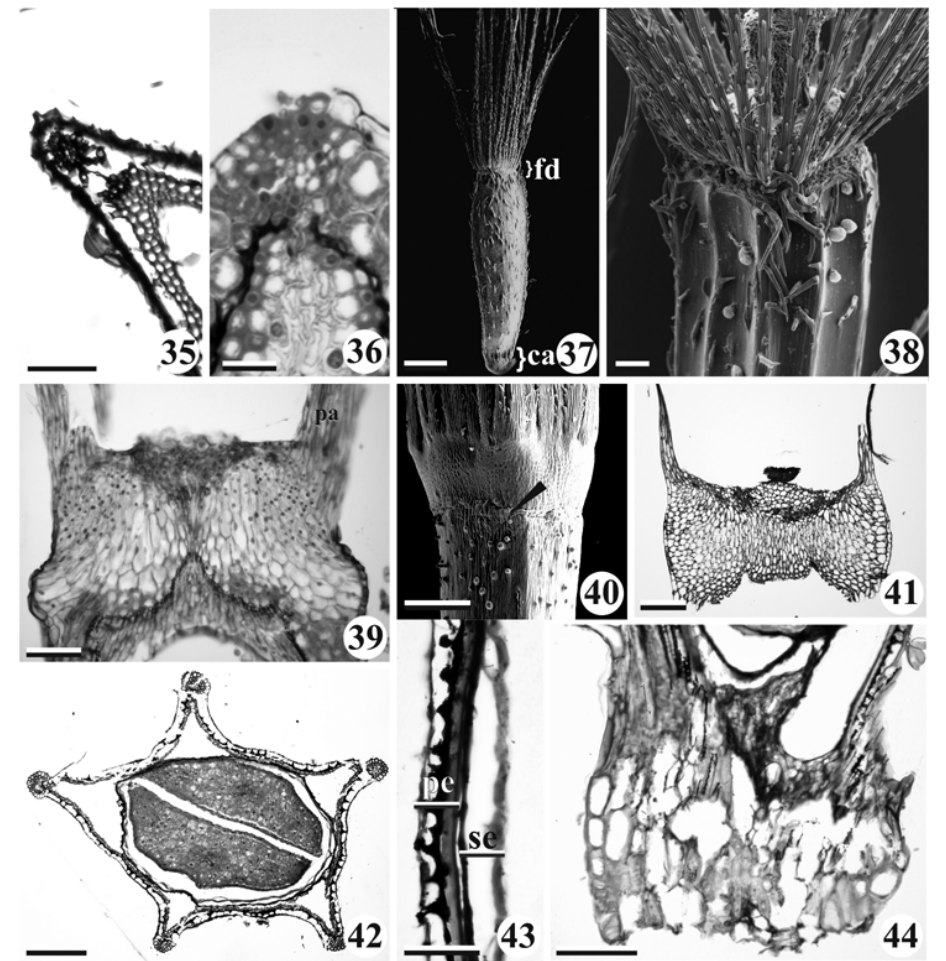
Fig. 3 – Cypselae during maturation. Figs. 35-36, 42-43 – Transversal sections. Figs. 39, 41, 44 – Longitudinal sections. Fig. 35 – Phytomelanin deposit in the external intercellular spaces of the vascular bundle of Symphyopappus reticulatus . Fig. 36 – Interruption of phytomelanin layer in the proximity of a vascular bundle in Chromolaena stachyophylla . Fig. 37 – Mature cypsela of Praxelis pauciflora . Figs. 38-39 – Detail of the micromorphology and anatomy of the floral disk region of Chromolaena stachyophylla respectively. Figs. 40-41 – Detail of the micromorphology (arrowhead – start of the fracture line) and anatomy of the pappus crown of Symphyopappus reticulatus . Figs. 42-43 – Mature pericarp of Campuloclinium macrocephalum . Fig. 44 – Carpopodium of Vittetia orbiculata showing lignified surface. (ca – carpopodium; fd – floral disk; pa – pappus; pe – pericarp; se – seed). Bars – 75 μ m (35); 20 μ m (36); 50 μ m (37); 100 μ m (38-39, 44); 30 μ m (40); 150 μ m